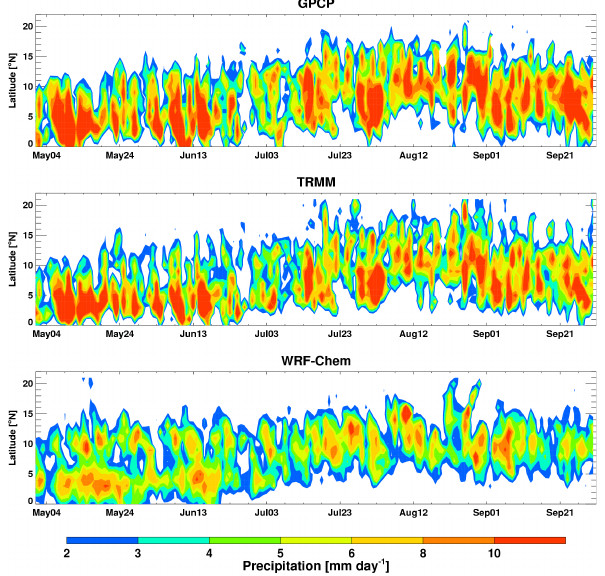
Fig. 5. Daily zonal averaged precipitation between 15 ◦ W–10 ◦ E from GPCP and TRMM measurements and the WRF-Chem control simulation.